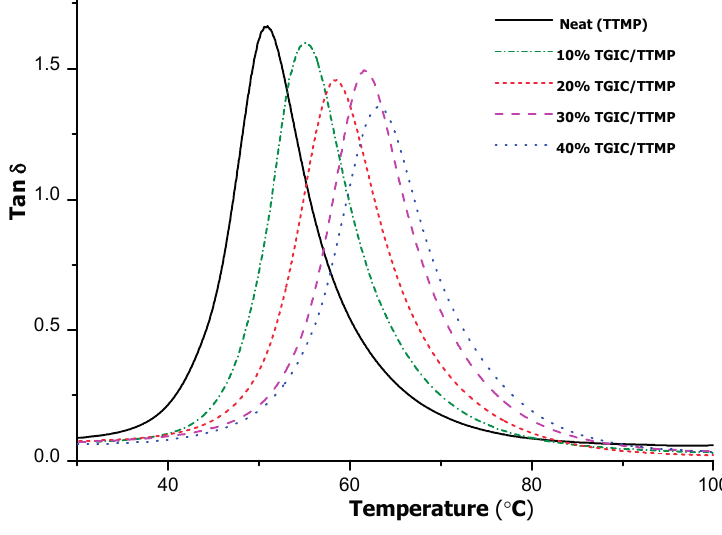
Figure 8. Plots of tan δ against temperature for the thermosets obtained for TTMP with different proportions of